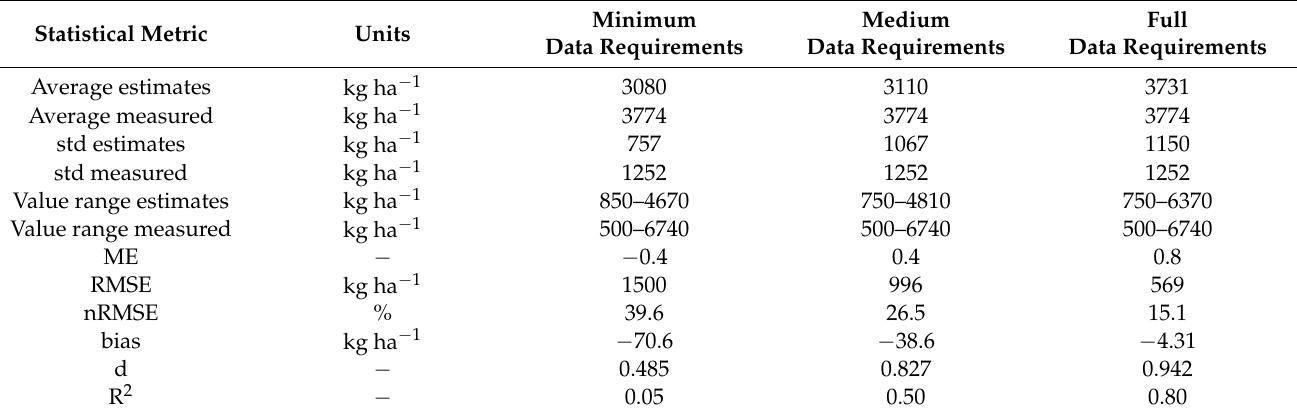
Table 5. Statistical evaluation of yield estimates with AquaCrop (n =